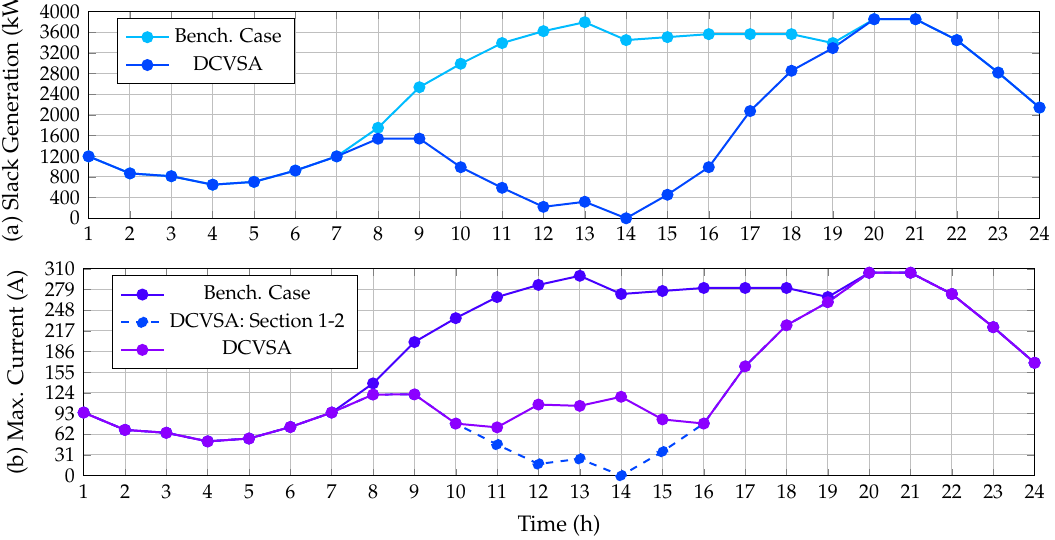
Figure 10. Impact of the PV inclusion in the DC version of the IEEE 33-bus system: ( a ) power injections in the slack source, and ( b ) maximum current performance.